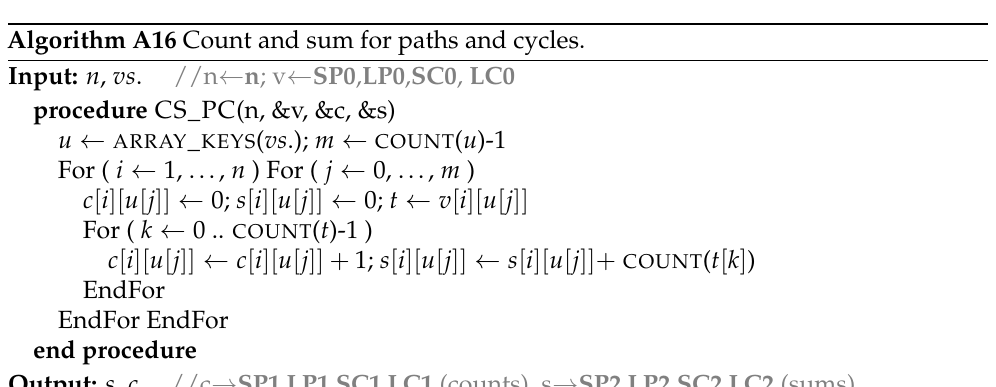
Algorithm A17 Set Szeged